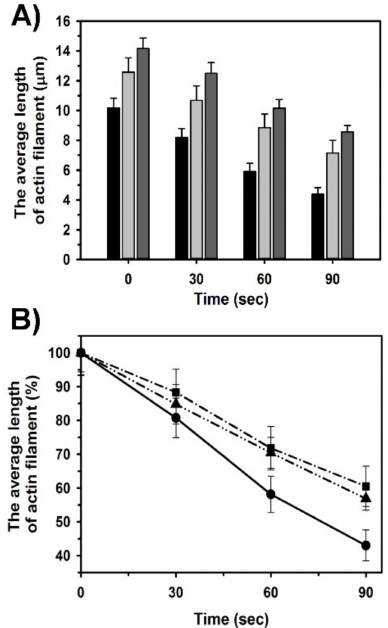
Figure 5. Tropomyosin-dependent regulation of actin filaments shortening by cofilin-2. ( A ) Averaged lengths of the filaments before and after exposition to cofilin-2. F-actin alone (black), F-actin in the presence of Tpm1.1 (light grey), Tpm3.12 (dark grey). ( B ) The rate of the actin filament depolymerization. The lengths of the filaments are shown as % of the lengths obtained before addition of cofilin-2. F-actin alone (circles, solid line), F-actin in the presence of Tpm1.1 (triangles, dash-dot-dot line), Tpm3.12 (squares, dash-dotted line). Conditions as in Figure 4 legend. The experimental errors are SE calculated in Excel (Microsoft O ffi ce Professional Plus 2013) from the lengths of 100 filaments. Analysis of statistical significance of di ff erences between F-actin, F-actin-Tpm1.1, and F-actin-Tpm3.12 in (A) showed that the di ff erences were significant ( p < 0.05); in ( B ) the di ff erences were statistically significant between F-actin and F-actin-Tpm1.1 or F-actin-Tpm3.12 at time points 60 and 90 sec ( p < 0.001) and not significant at 30 sec ( p = 0.259); the di ff erence between F-actin-Tpm1.1. and Tpm3.12 was not significant within the whole time range ( p >